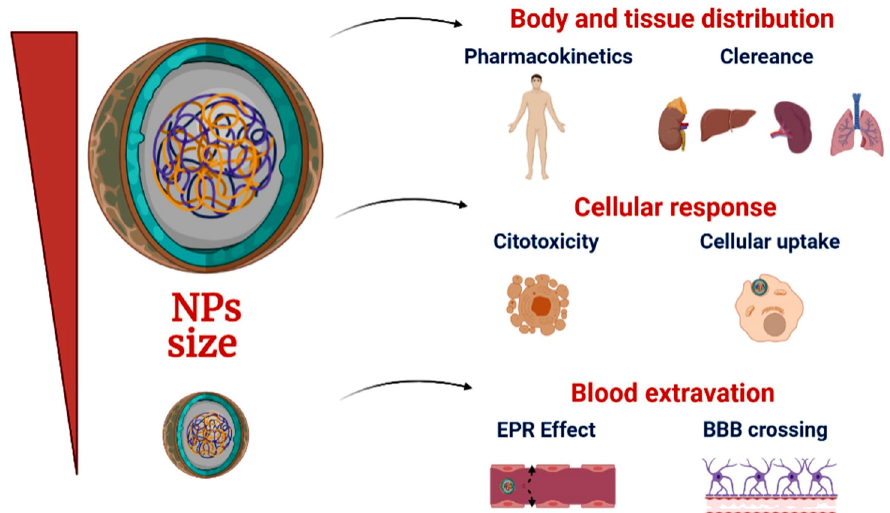
Figure 2: E ff ect of nanoparticles size on body and tissue distribution, cellular response, and blood extravasation. Depending on the size, NPs can localize di ff erently in body compartments ( pharmacokinetics ) and can cleaned from di ff erent organs: kidney (< 5 nm ) , liver ( 10 – 20 nm ) , spleen ( 20 – 200 nm ) , and lung ( inhaled NPs > 100 nm ) . Cellular response exploited cytotoxicity and cellular uptake mediated by micropinocytosis ( big NPs ) , clathrin - mediated endocytosis ( 100 nm ) and caveolae - mediated endocytosis ( 15 – 80 nm ) . NPs size in fl uence also the EPR e ff ect for passive tumour targeting and the cross thought